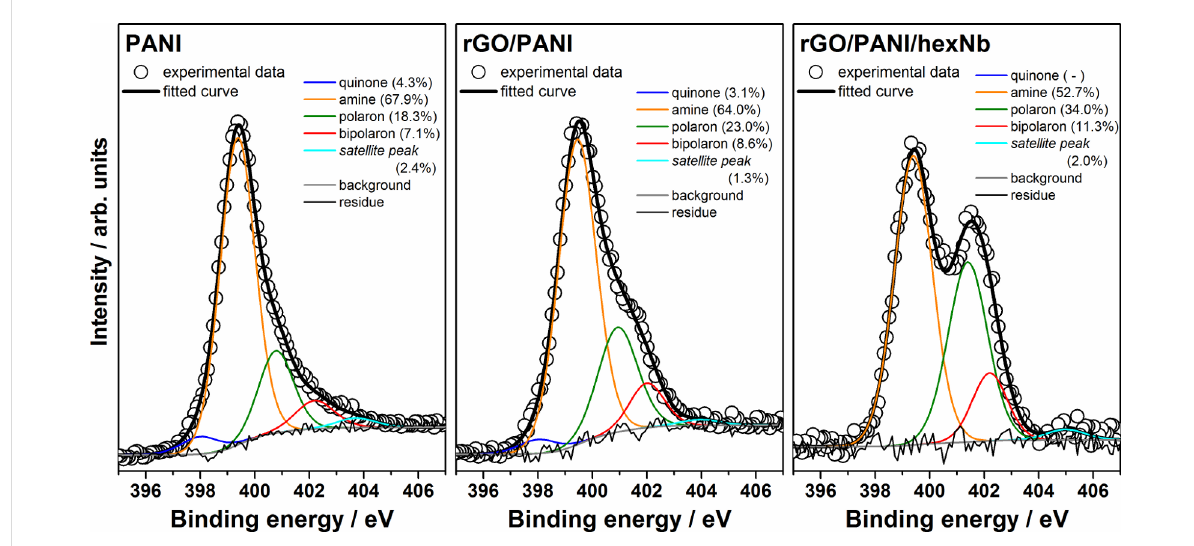
Figure 5: XPS spectra at N 1s core level of PANI and nanocomposites rGO/PANI and rGO/PANI/hexNb.